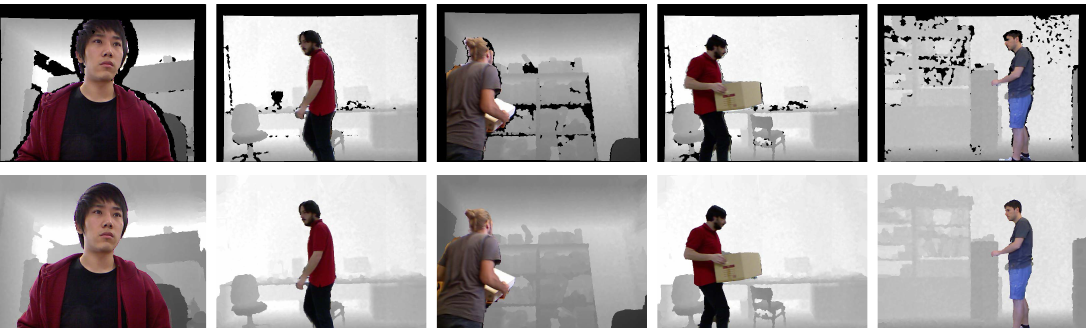
Figure 16. The synthesized object image by using the object depth regions. Top row is based on the original depth image (Figure 15b). Bottom row is based on the enhanced depth images (Figure